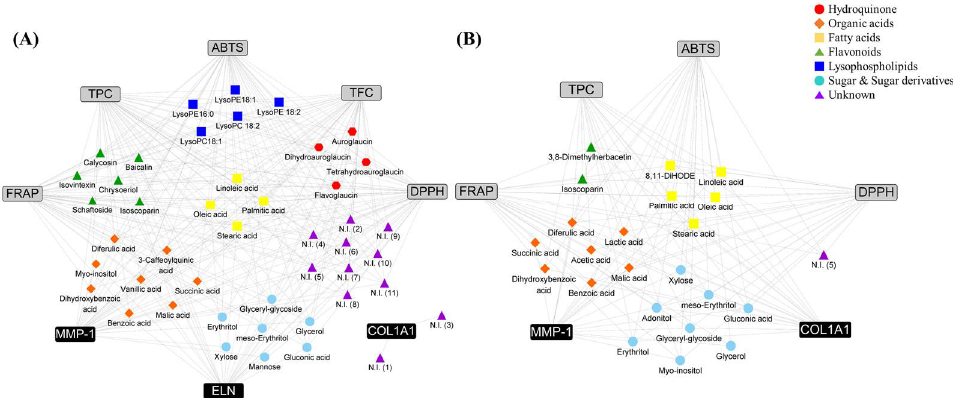
Figure 4. The metabolites that have a Pearson’s correlation coefficient value higher than 0.5 are represented by a network map in rice koji fermented with ( A ) Aspergillus cristatus or ( B ) A. oryzae . The box symbols represent bioactivities (gray color, antioxidant activity, TPC and TFC; black color, skin anti-aging effect on cell) and the colored symbols indicate the metabolites (same series were distinguished by different color and shape; ●, hydroquinone; ◆ , organic acids; ■ , fatty acids; ▲ , flavonoids; ■ , lysophospholipids; ●, sugar and sugar derivatives; ▲ , unknown).